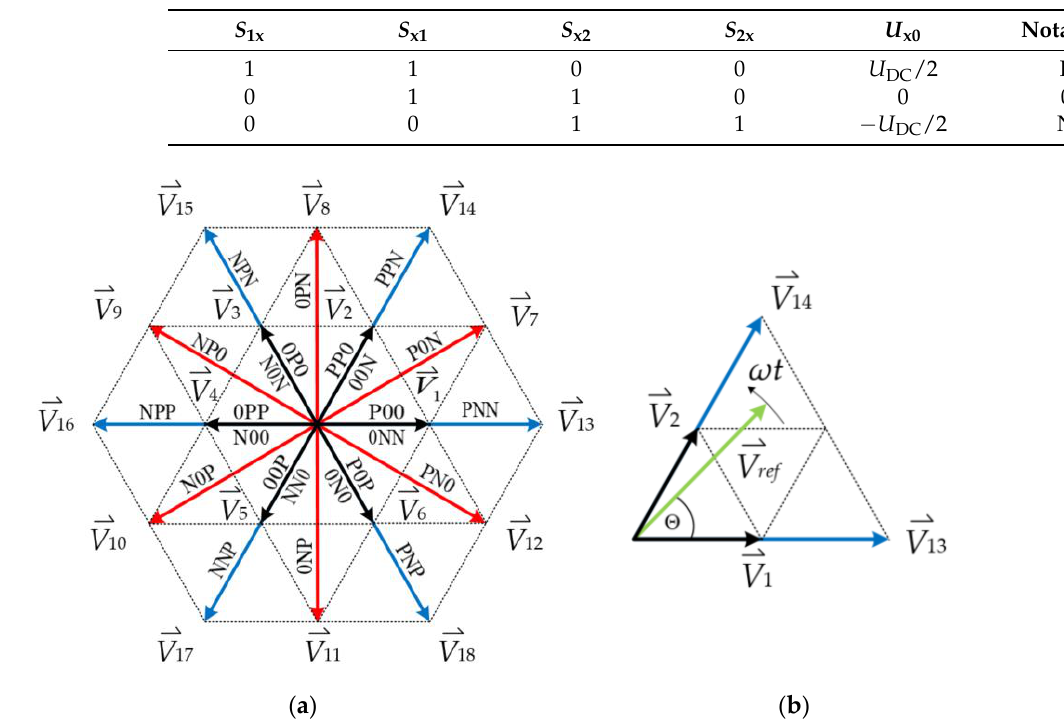
Figure 2. ( a ) Vector diagram for a three-level inverter; ( b ) reference voltage vector positioned in the first